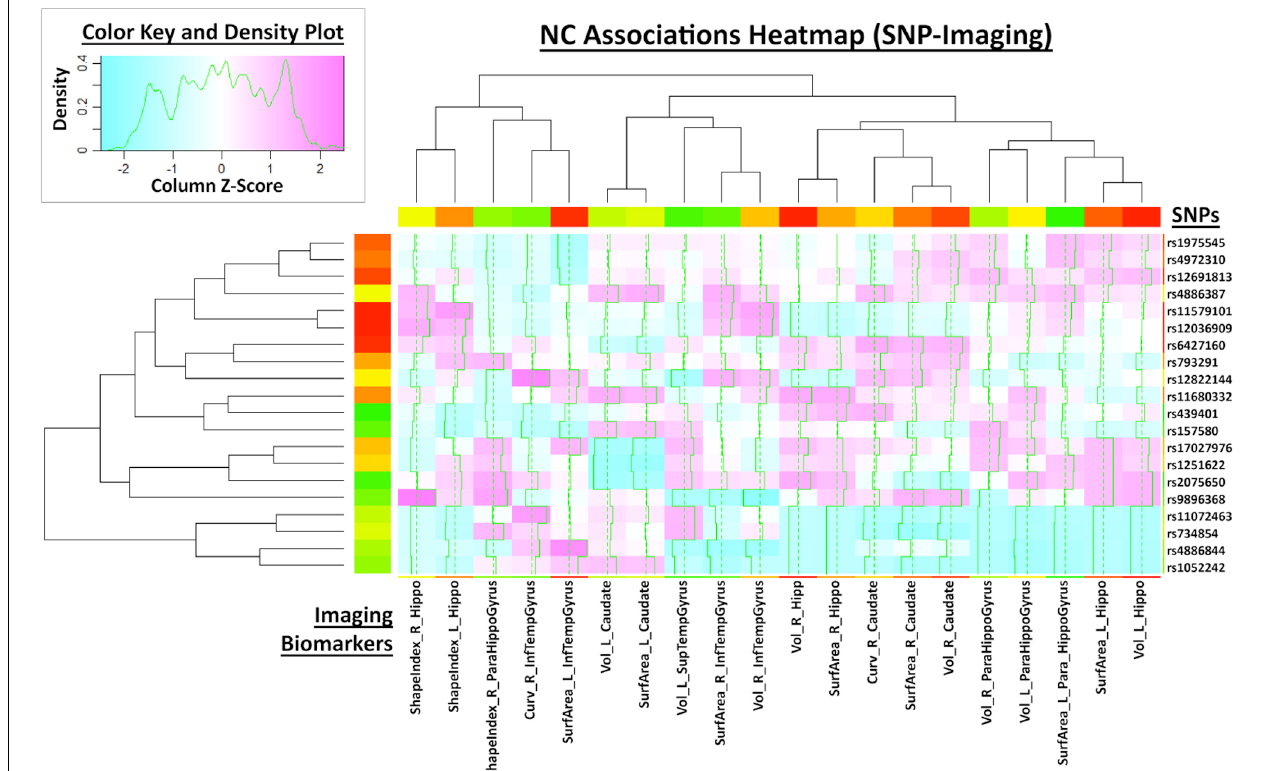
FIGURE 4 | Heatmap plot of 20 neuroimaging derivative measures associated with the subject phenotype (columns) and the SNP